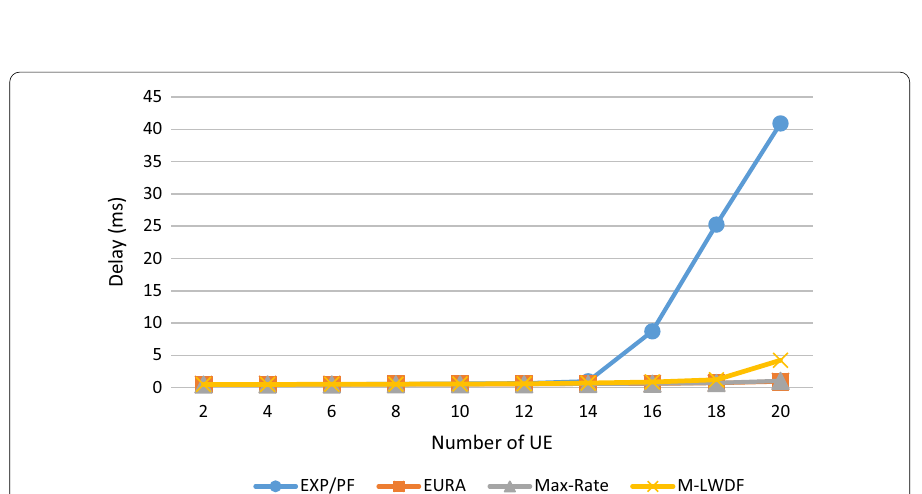
Fig. 13 Simulation result of delay; The performance comparison of delay for our proposed scheme and the